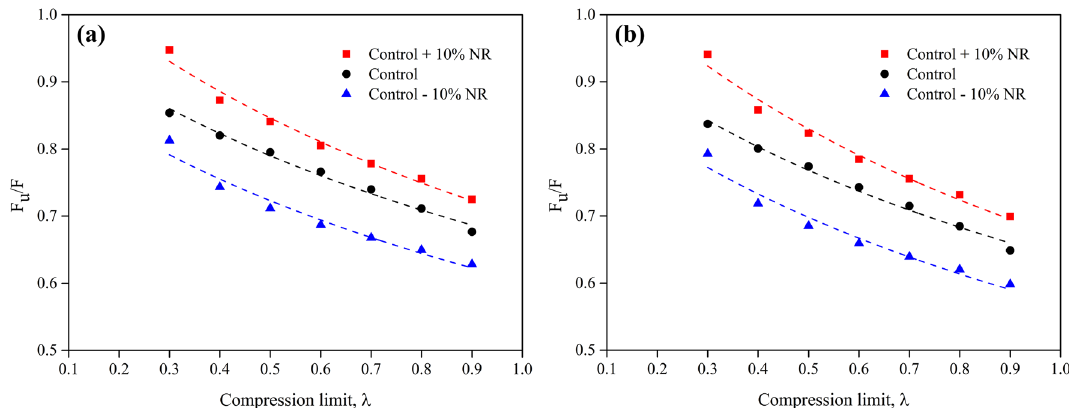
Figure 9. Internal energy contribution vs the compression force, F u /F, of various foam samples: ( a ) 298.15 K, and ( b ) 338.15 K. The scatter on the results is on the order of the size of the